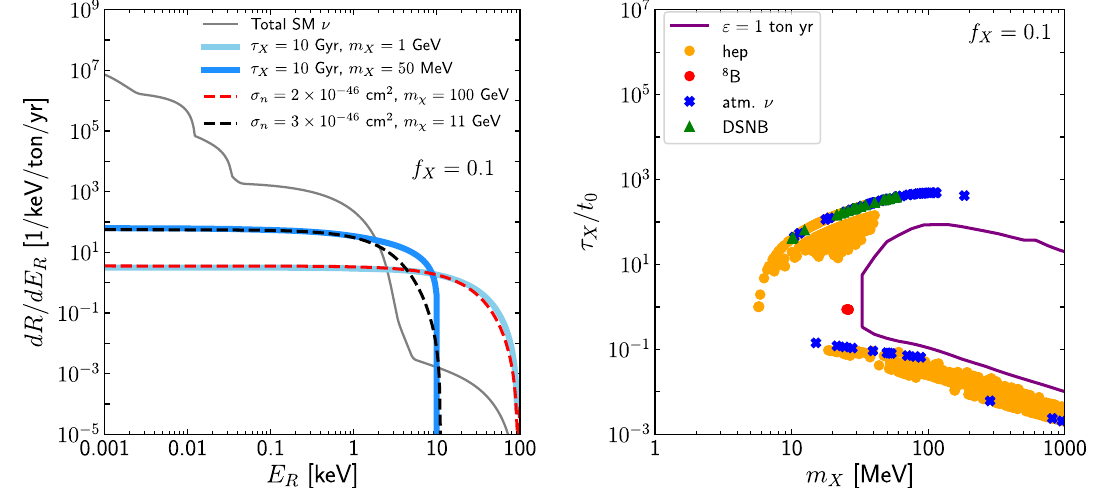
Fig. 9 Left: Best fit WIMP recoil spectra (dashed lines) which mimic the DR recoils (cyan solid lined) with progenitor lifetime of 10 Gyr and progenitormassof50 MeV(left)and1GeV.Thetotalstandardneutrino recoilratesarealsooverlaid(solidgrey).Right:Contributionsfromeach